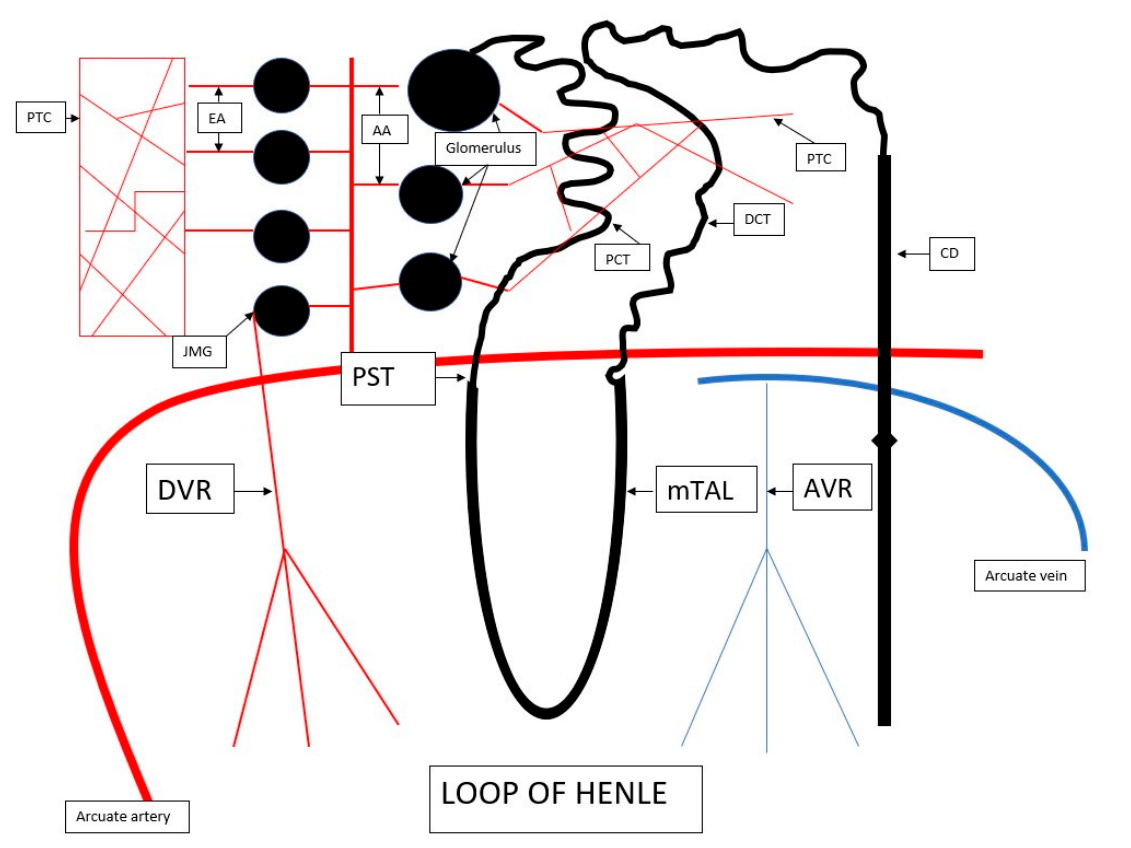
Figure 1. Renal microcirculation anatomy—the nephrovascular unit.